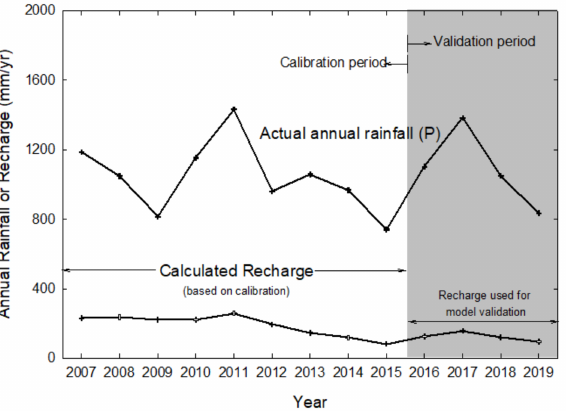
Figure 16. Variability of recharge over a period of 2007–2015 (from calibration), with a Pearson’s correlation coefficient between precipitation and recharge of